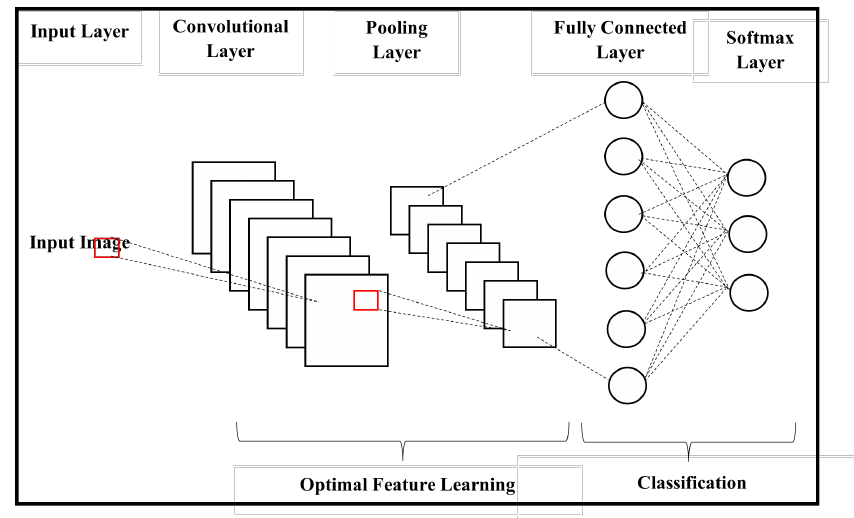
Figure 3. Outline of deep CNN with